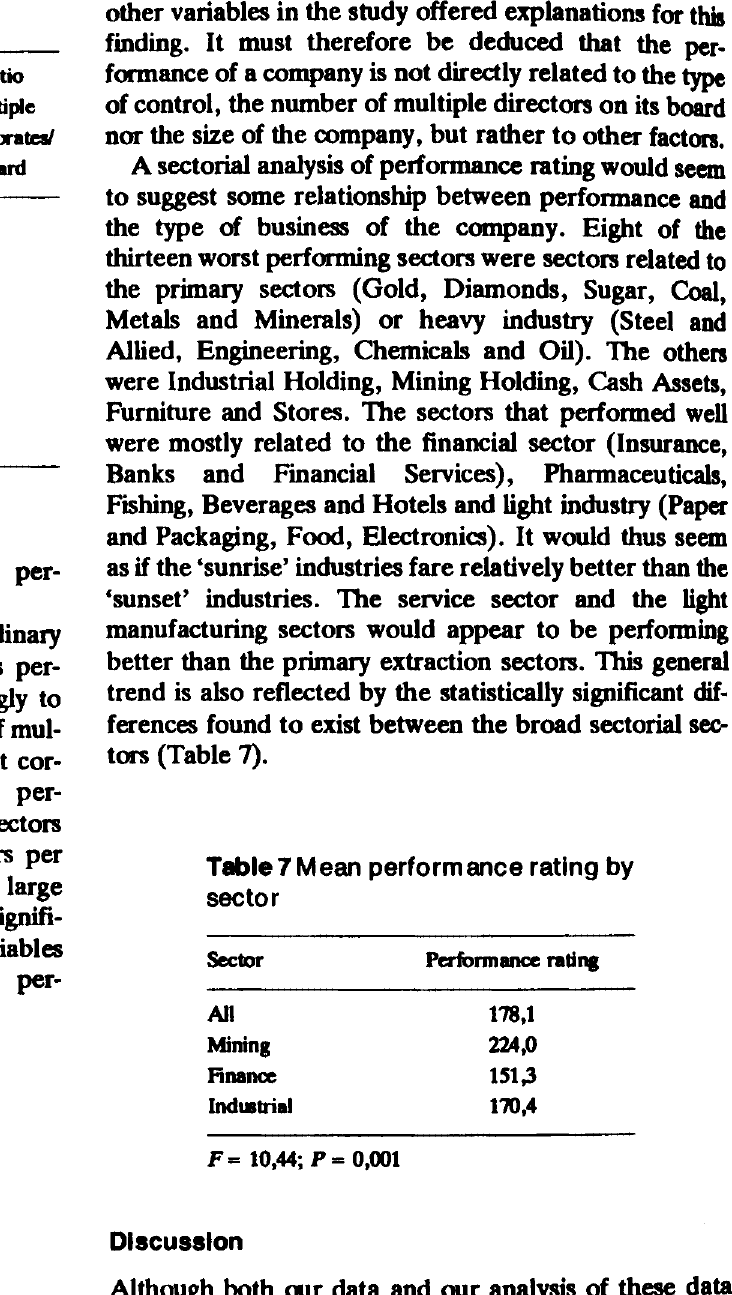
Table 6 Mean rating•by type of control